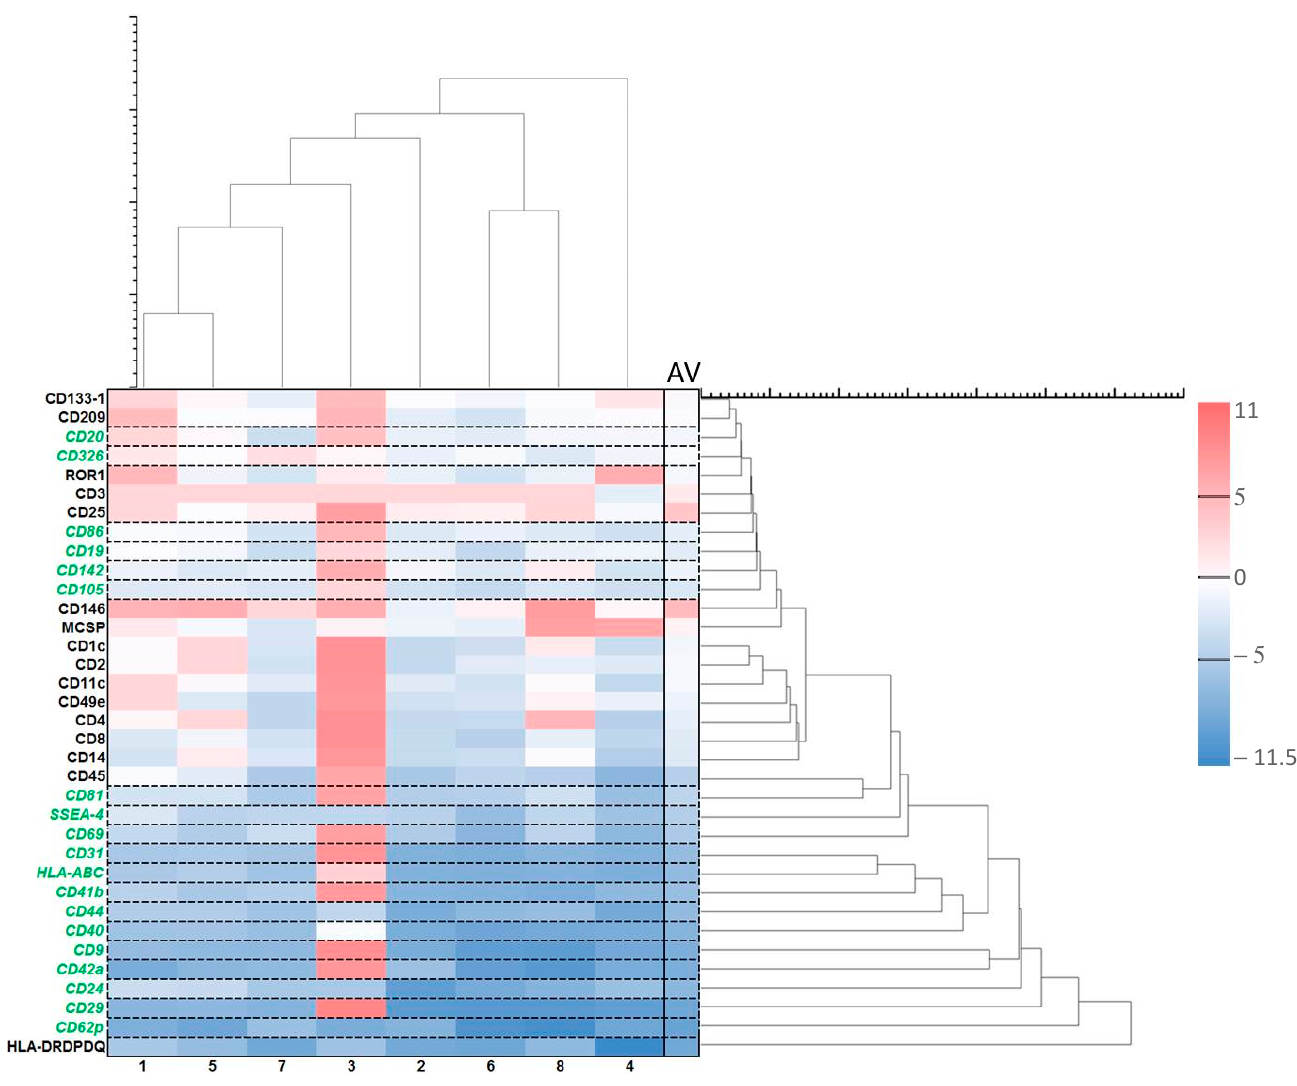
Figure 9. Effects of ALA and red light on exosomes. Exosome heatmap with log values. Log = sgn(PDT i − ALA i )*log 2 (|PDT i − ALA i |), where PDT i is the exosome fluorescence intensity in the group with ALA plus light and ALA i is the exosome fluorescence intensity in the group with ALA alone. The pink colors represent increased exosomes while the blue ones show decreased exosomes after treatment with ALA plus light. The heatmap is vertically clustered by log Euclidian distances and also horizontally clustered by various patient samples. The selected exosomes with the lowest variabilities are shown with the green color. AV is an average of the log values from different sam- ples of eight patients.